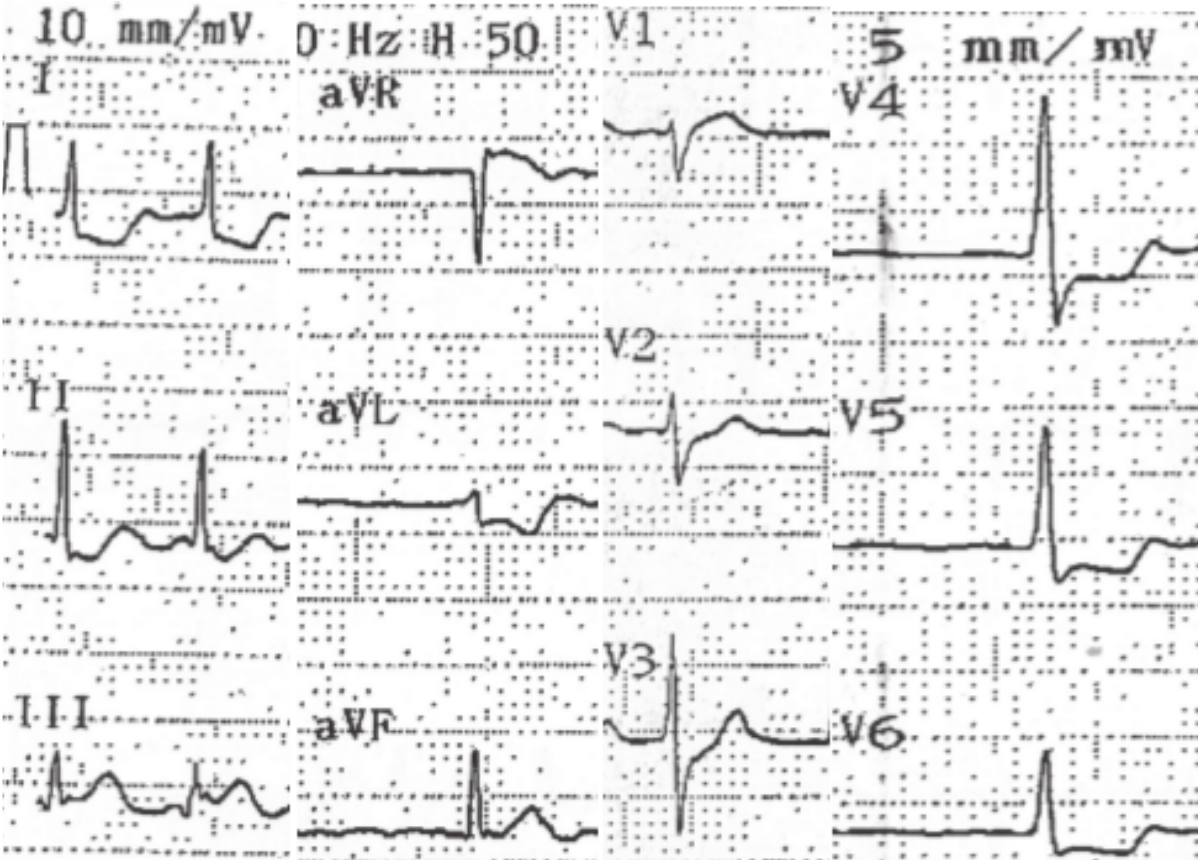
Figure 1: Electrocardiogram showing ST elevation in D3 and aVF leads and ST depression in leads exploring the lateral wall of the left ventricle.